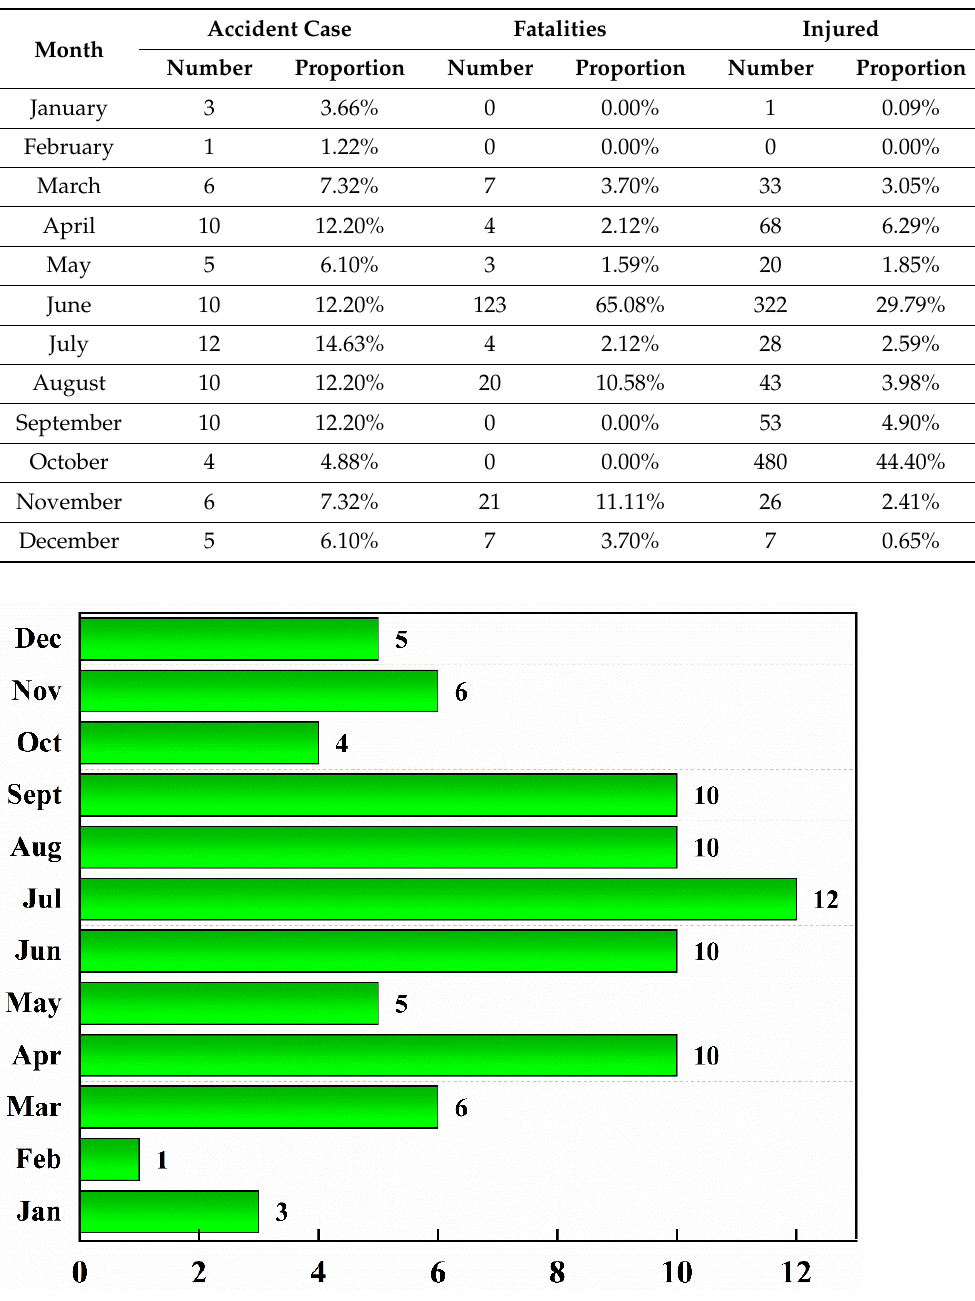
Table 3. Number of Accident cases, fatalities, and injuries by month.